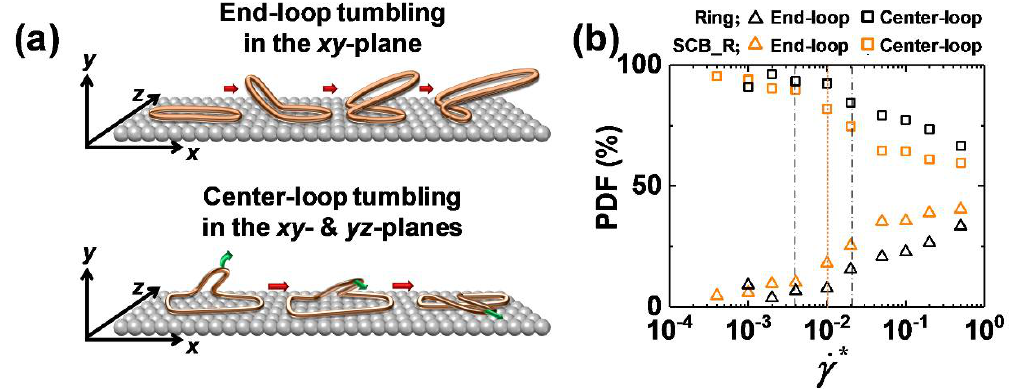
Figure 6. ( a ) Schematic depiction of the two types of loop tumbling mechanisms (end-loop tumbling and center-loop tumbling) of the interfacial ring chains. ( b ) Proportion of end-loop tumbling (triangles) and center-loop tumbling (squares) of the interfacial chains as a function of the shear rate for the pure ring (black symbols) and SCB ring (orange symbols) polymers. The vertical lines have the same meaning as in Figure 1.